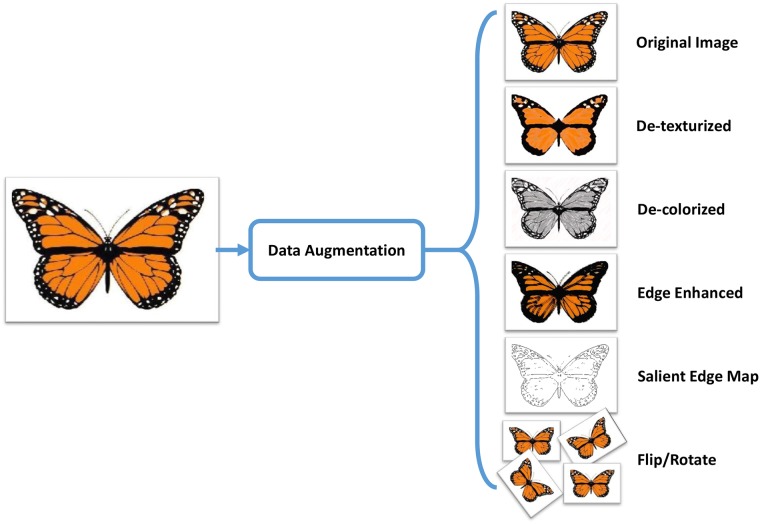
Data augmentation using semantic-preserving transformation for SBIR.